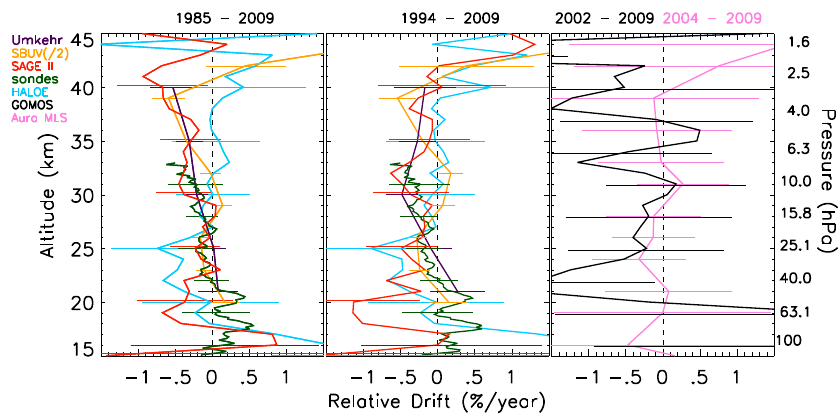
Fig. 10. Vertical distribution of the slopes calculated from monthly average of the relative differences of long-term (left and middle panels) and short-term (right panel) data sets with lidar data. The slopes are estimated in two periods, in 1985–2009 and 1994–2009, for the long- term data. The beginning (e.g. 1985, 1994, 2002, 2004) and ending (2009) year of the analyses depend on the availability of the respective observations during the period. Please see the text for more details. The dashed vertical line represents 0% yr − 1 and the error bars represent twice the standard deviation of the slope. Approximate pressure levels corresponding to the geometric altitudes are also shown on the right axis.